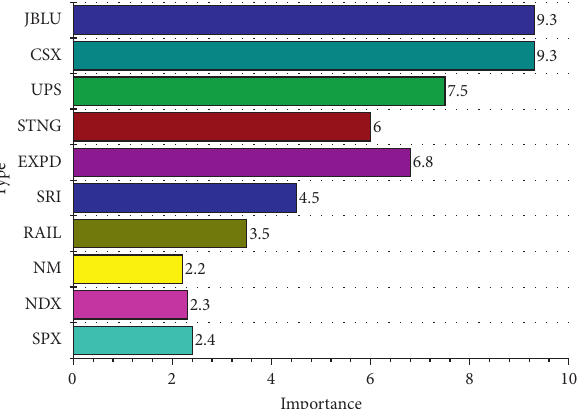
Figure 8: Regression tree model.